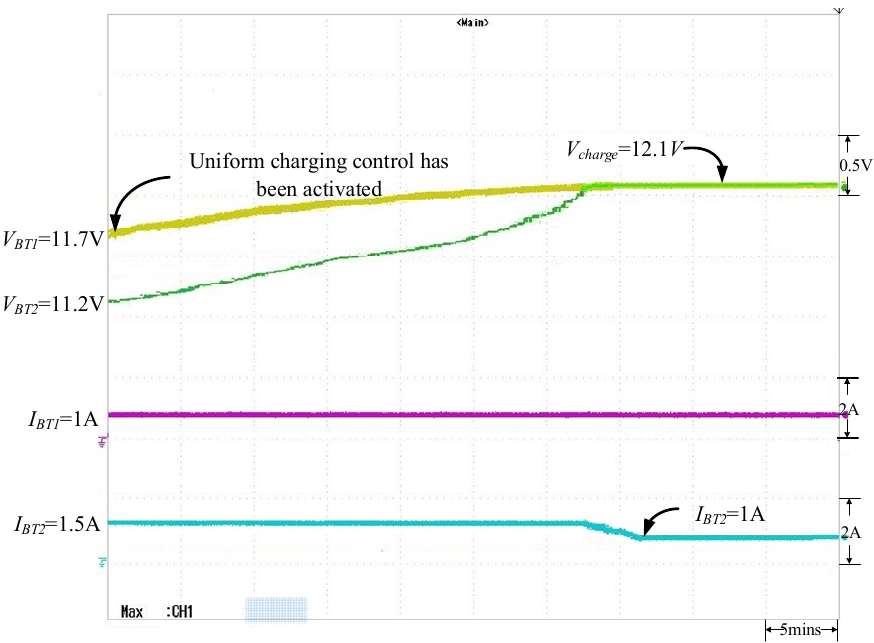
Figure 18. The uniform charge control response when V BT 1 = 11.7 V and V BT 2 = 11.2 V.